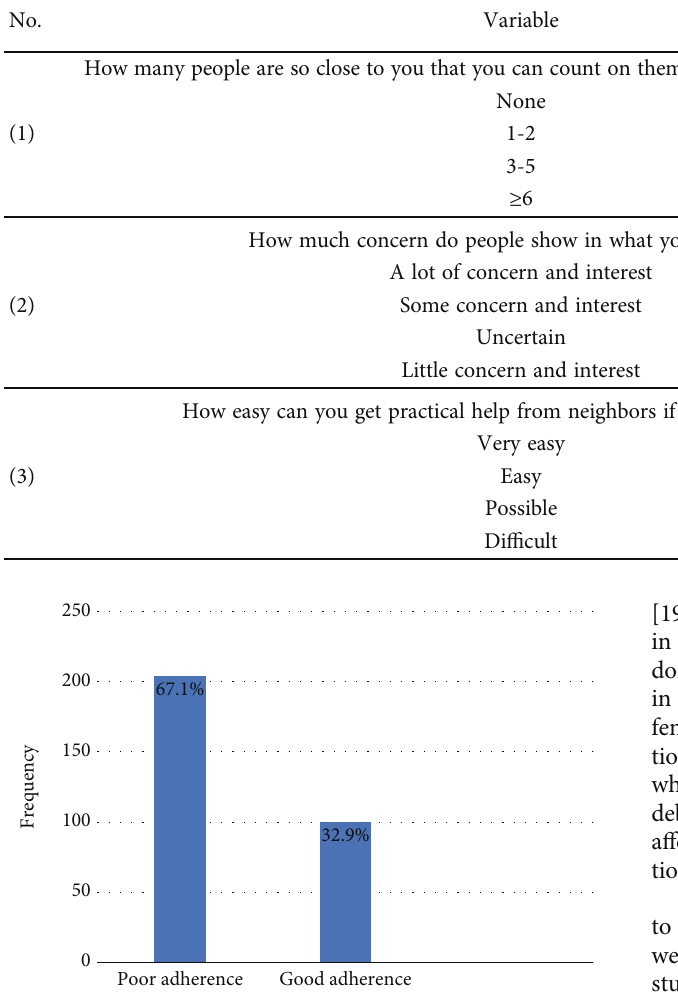
Table 5: Social support of HF patients in West Gojjam Zone public hospitals, Northwest Ethiopia, 2021 ( N = 304 ). No.